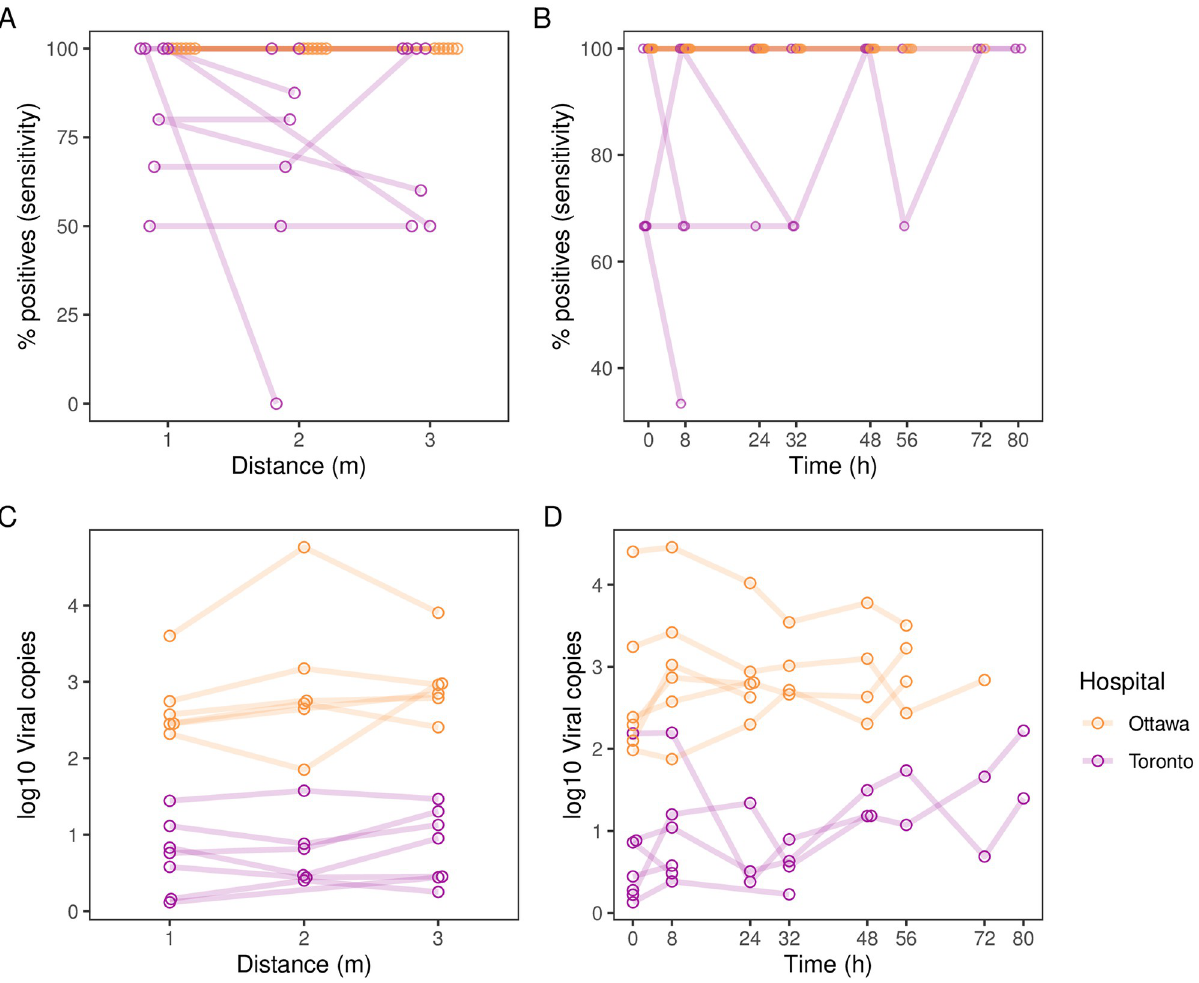
Fig 1. Detection of SARS-CoV-2 (positivity and viral copies) in COVID-19 patient rooms over (A & C) space and (B & D) time. m = metre, h = hour. Distance was measured from the patient’s bed, with 3 m indicating where the room connected with the hallway (typically 3 m to 5 m from the patient’s bed). Time 0 is the first swab sample